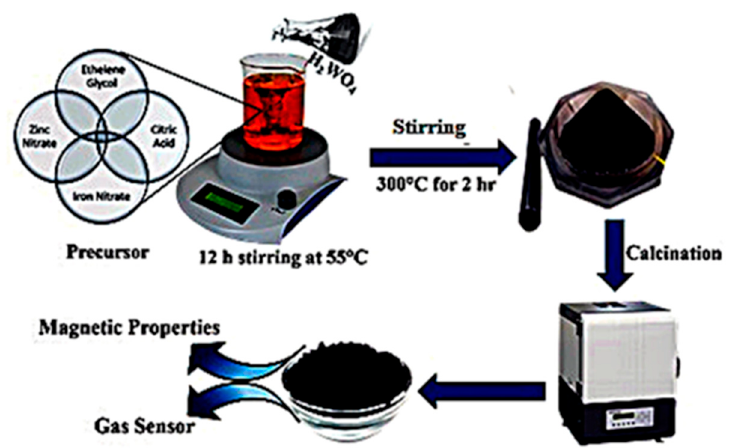
Figure 1. Synthesis of pure ZnFe 2 O 4 and W-substituted ZnFe 2-2x W x O 4 (0.0 ≤ x ≤ 0.15) nanoparticles via a sol–gel method.